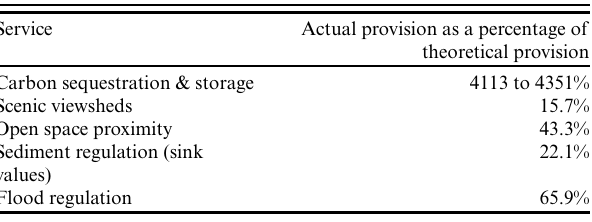
Table 3 . Overall ratios of actual to theoretical service values in the Puget Sound Basin.